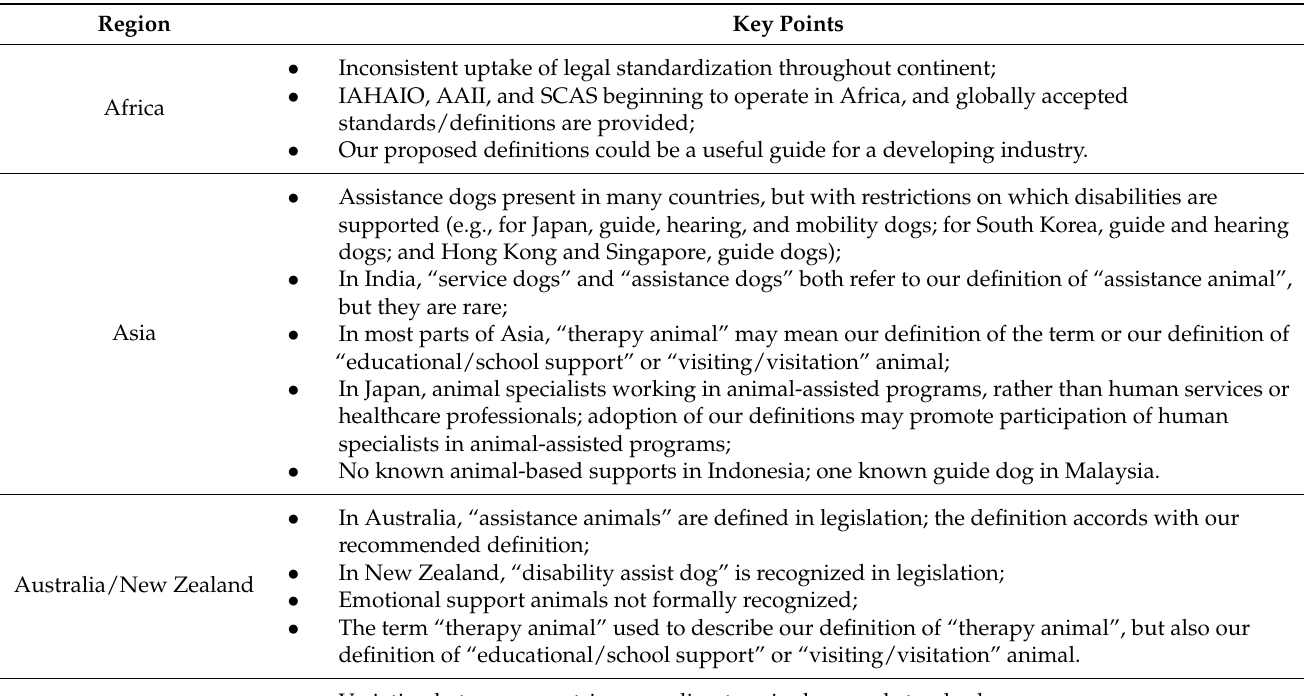
Table 2. An overview of the implications of our proposed definitions for various regions of the